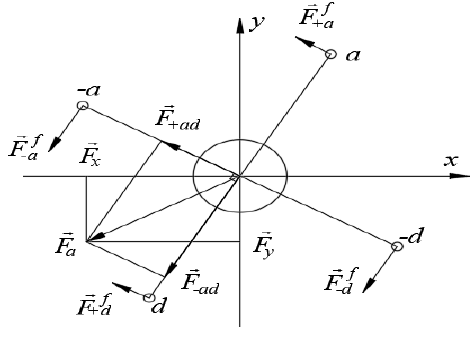
Figure 7. Bearing